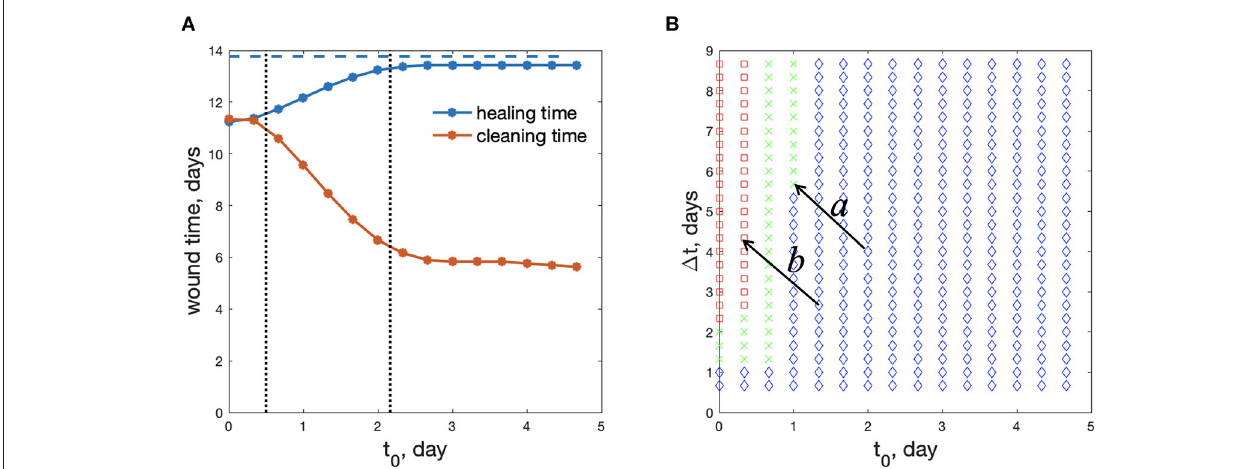
FIGURE 7 | Optimal regimes of wound treatment. (A) wound healing time and wound cleaning time as functions of treatment beginning time, t 0 ( 1 t = 2d8h). Blue dashed line: healing time without treatment. (B) Parametric plane for the choice of the treatment regime: green crosses – the safe and beneficial regimes of treatment; red squares – wound cleaning takes a longer time than wound healing; blue diamonds – wound healing time diminishes less than 10% in comparison with the non-treated wound ( r p =0.6 mm). Arrows labeled “a” and “b” represent the same change in treatment strategy but demonstrate different outcomes due to different reference